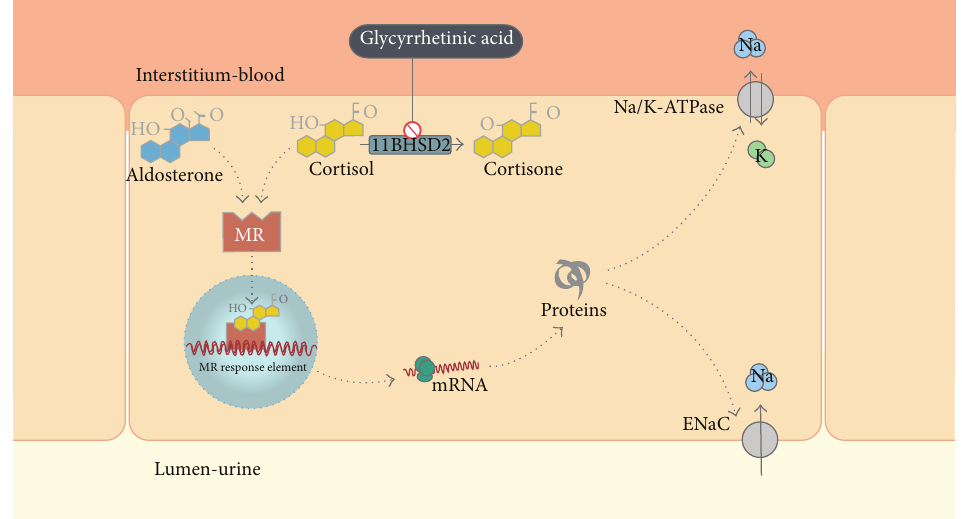
Figure 2: Aldosterone acts primarily in the distal nephron by diffusing into the tubular cell and attaching to specific mineralocorticoid receptor (MR). After that, the ligand-receptor complex migrates into the nucleus, where it interacts with specific sites and enhances messenger RNA (mRNA) and ribosomal RNA transcription. Aldosterone-induced proteins are synthesized, such as the apical epithelial sodium channel (ENaC) and basolateral Na/K-ATPase. In vitro , aldosterone and cortisol have similar affinity to the MR. The enzyme 11 𝛽 -hydroxysteroid dehydrogenase type 2 (11BHSD2) converts cortisol to inactive cortisone, preventing cortisol from binding to the MR. Glycyrrhetinic acid inhibits 11BHSD2 leading to activation of MR by